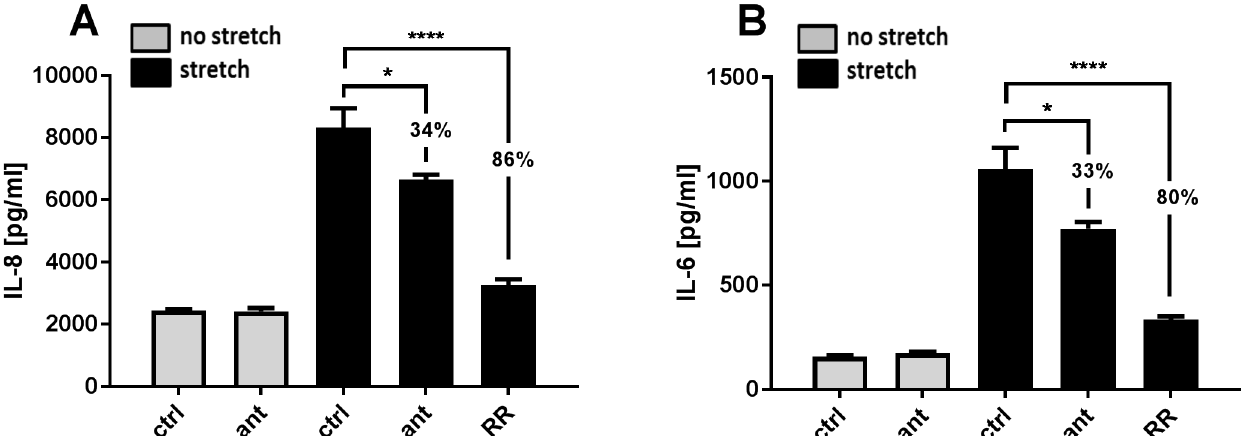
Fig 4. TRPV4 mediated stretch-induced cytokine release. Repesentative experiment of NCI-H292 cells seeded on silicoelastic membranes and exposed to cyclic equibiaxial stretch (cyclic 30% strain with 1.25 hz) for 24 h in the presence or absence of the TRPV4-Antagonist GSK2193874 [1 μ M]. (A) Stretch induced release of IL-8 compared to unstretched control (ctrl) reduced by 34% with the TRPV4 antagonist (ant) and reduced by 86% with Ruthenium Red (RR). (B) IL-6 release via stretch that was reduced through TRPV4 antagonism by 33% (ant) and reduced by 80% with Ruthenium Red addition (RR). Data are mean ± SEM; (n = 3; (cid:3) p < 0.05; (cid:3)(cid:3)(cid:3)(cid:3) p < 0.0001 vs stretch control; one-way ANOVA Tukey’s multiple comparisons